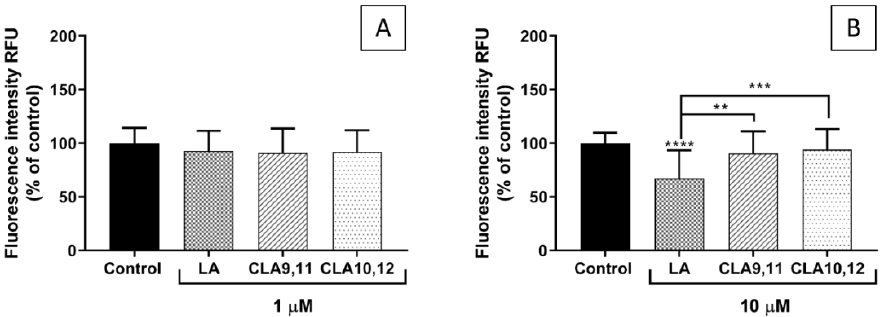
Figure 4. Adhesion of THP-1 cells (% of control) to EA.hy926 cells incubated for 48 h with a medium containing 0.1% of ethanol (Control) or different concentrations (1 µ M ( A ), 10 µ M ( B )) of fatty acid, followed by incubation with a medium without fatty acids for 6 h and then 1 h co-incubation with THP-1 cells. Bars are mean ± SD of 9 samples from 3 experiments. Data were analysed using the one-way ANOVA with Tukey post hoc test. ** p < 0.01; *** p < 0.001; **** p < 0.0001; where asterisks are shown immediately above a bar they refer to the difference from the control and where asterisks are shown above a horizontal line they refer to the differences between the two groups indicated by that line. LA, linoleic acid; CLA9,11, cis -9, trans -11 linoleic acid; CLA10,12, trans -10, cis -12 linoleic acid. The fluorescence microscopy images support the quantitative results, showing a lower number of THP-1 monocytes (green spots) adhering when ECs were pre-incubated with LA at a concentration of 10 μ M (Figure 5B).